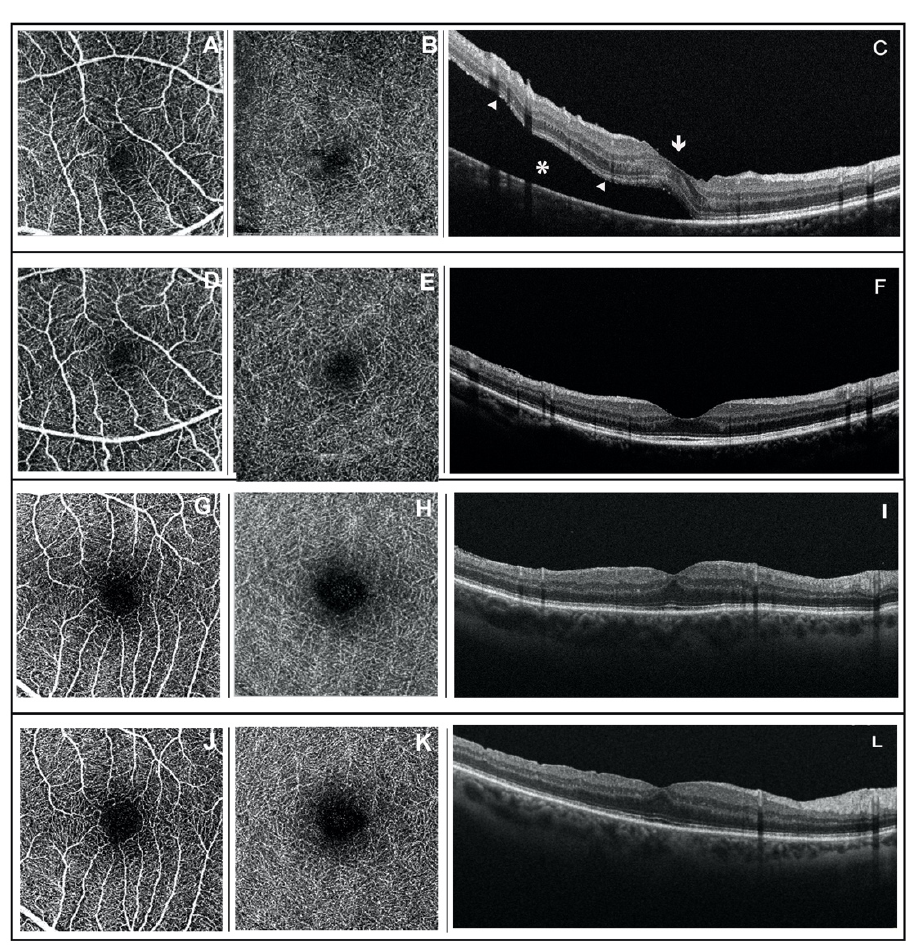
Figure 1. Foveal avascular zone area analysis on optical coherence tomography angiography en-face 3 × 3 images and optical coherence tomography B-Scan in bisected macula rhegmatogenous retinal detachment eye ( A – F ) and not bisected macula rhegmatogenous retinal detachment eye ( G – L ). ( A , G ) Superficial capillary plexus at preoperative time; ( B , H ) deep capillary plexus at preoperative time; ( C , I ) preoperative OCT B-scan of bisected and not bisected macula retinal detachment, respectively. In the bisected macula group, the subretinal fluid (*) determines a separation of the neurosensory retina (white arrowhead) from the retinal pigment epithelium that transects the fovea (white arrow), despite that, the fovea remains morphologically intact. ( D , J ) Superficial capillary plexus at postoperative time; ( E , K ) deep capillary plexus at postoperative time; ( F , L ) postoperative OCT B-scan of bisected and not bisected macula retinal detachment. In the bisected macula group, restoration of normal morphology has occurred following retinal detachment repair.